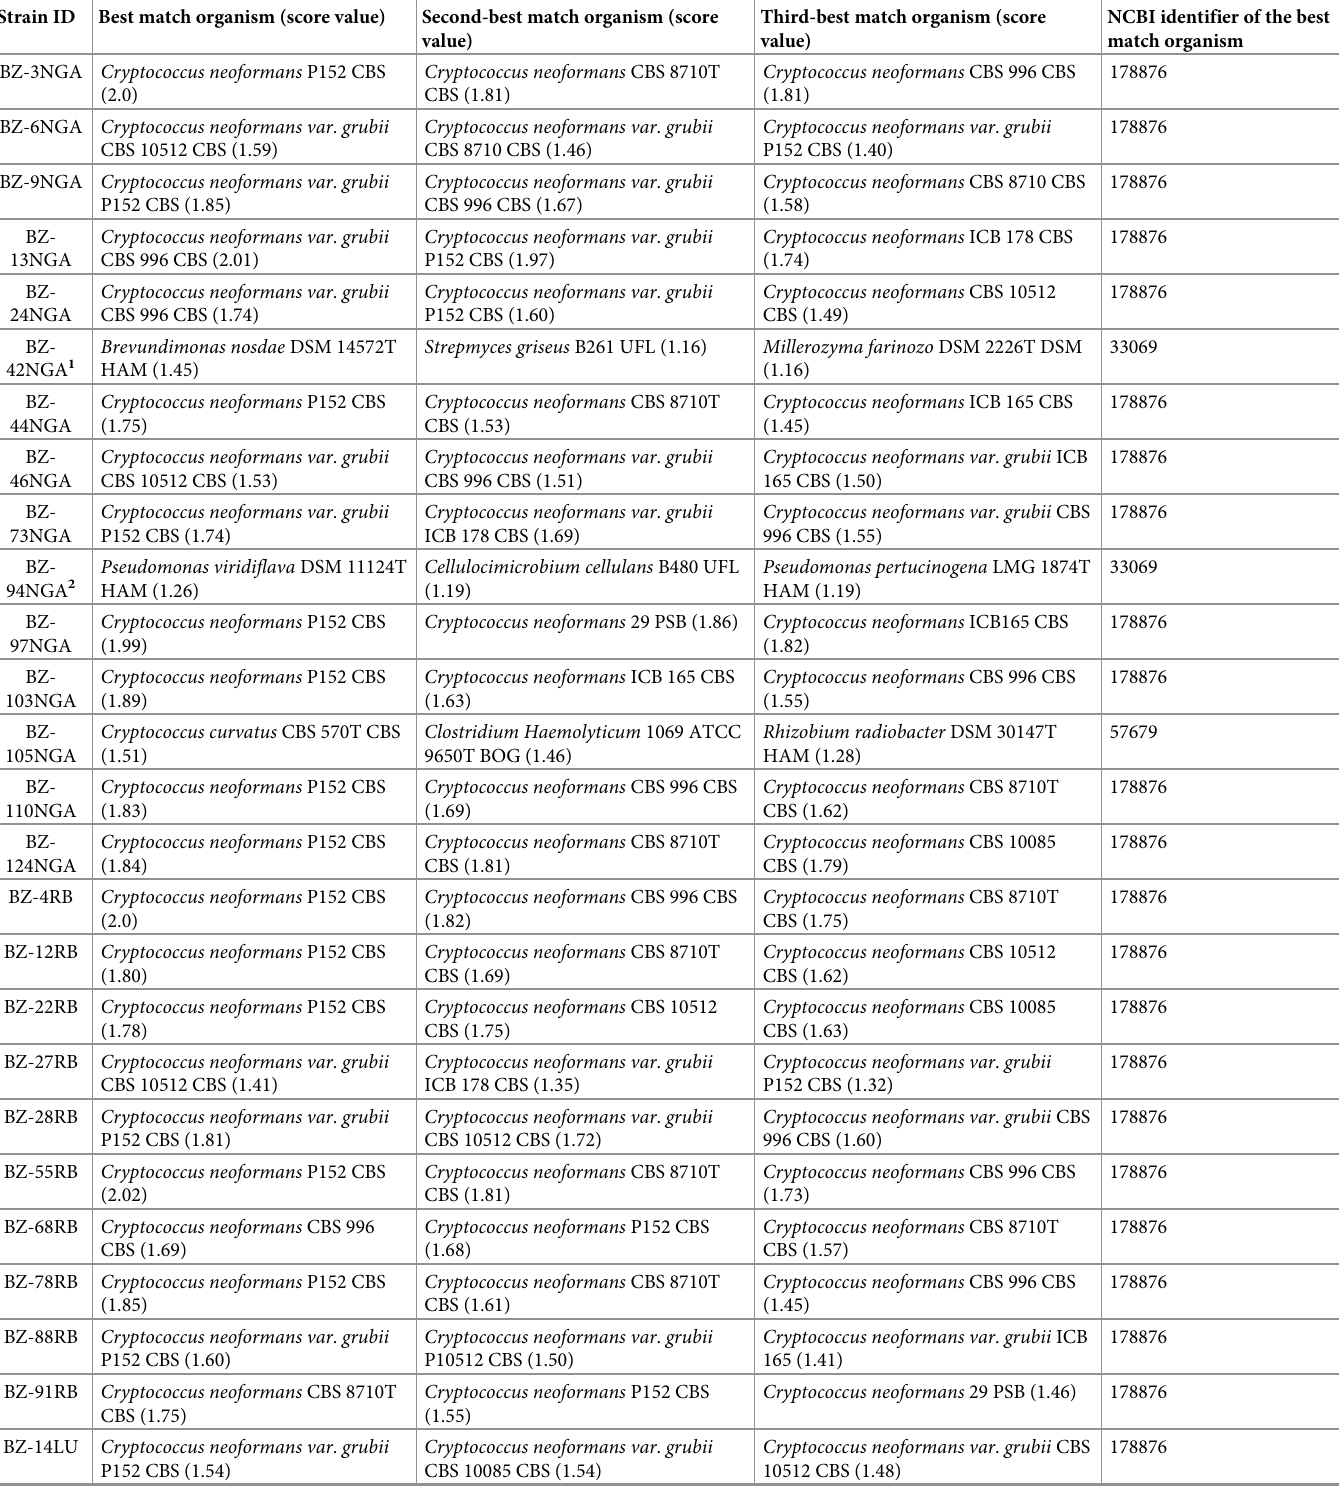
Table 3. MALDI-TOF MS detailed findings. Strain ID Best match organism (score